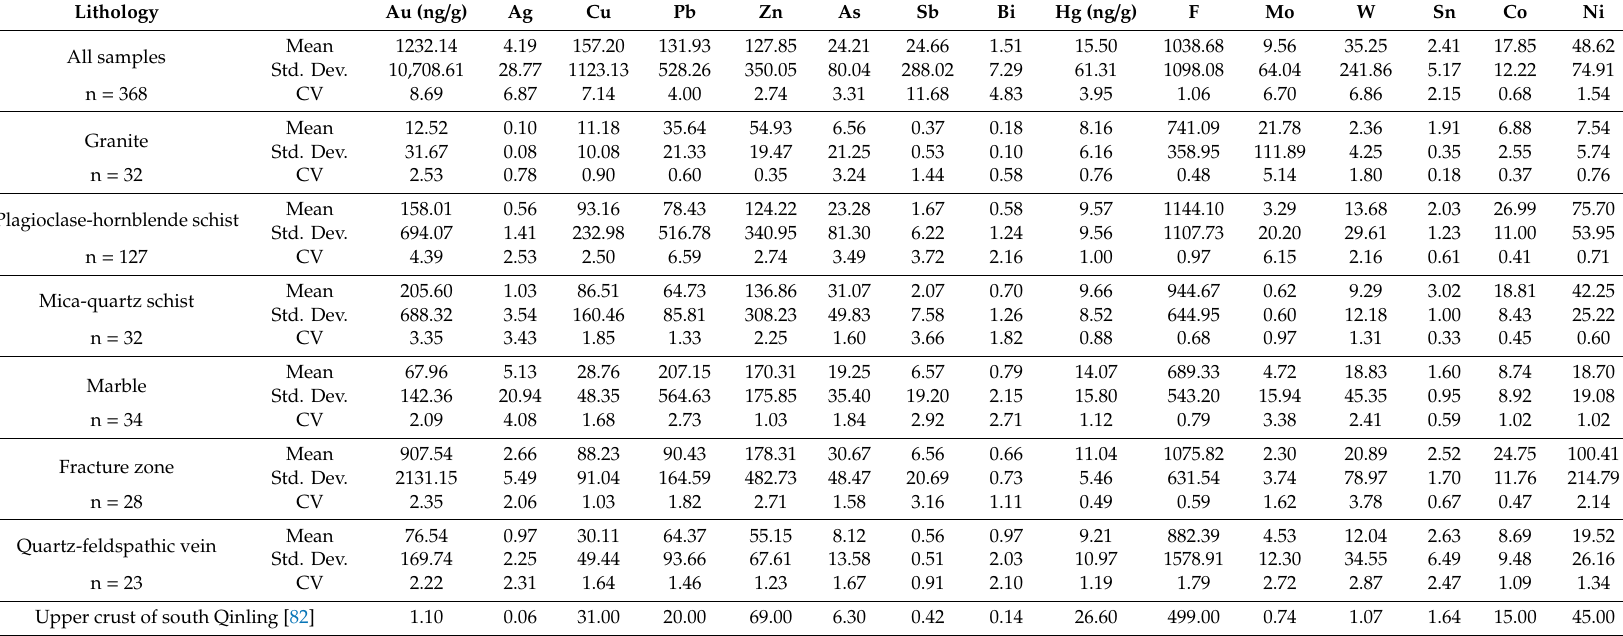
Table 2. Geochemical characteristics of trace elements in di ff erent lithologies in Laowan gold deposit (the units of the elements are ppm except Au and Hg). Lithology All samples